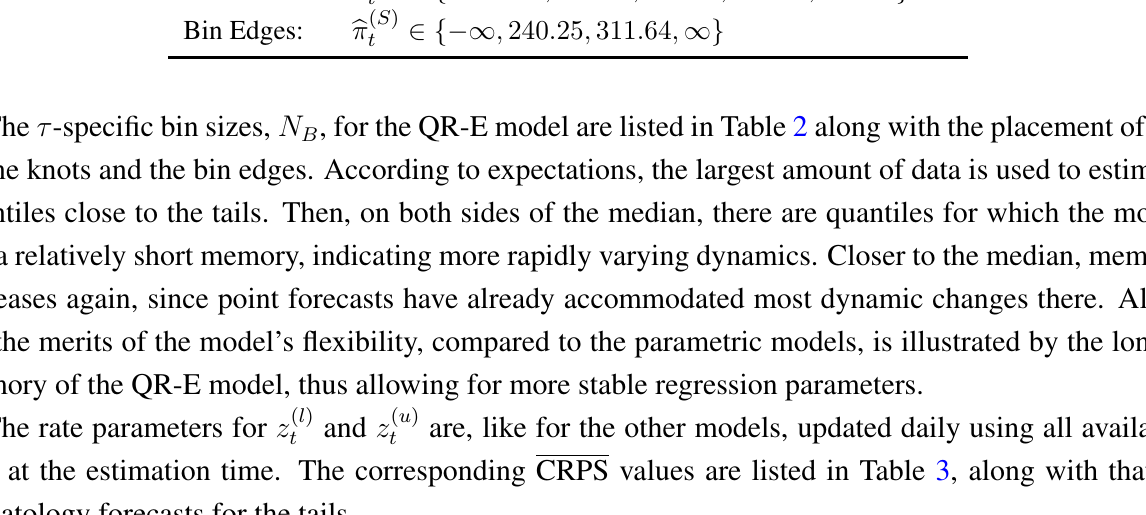
Table 3. The CRPS for the tail models, estimated for τ ∈ τ